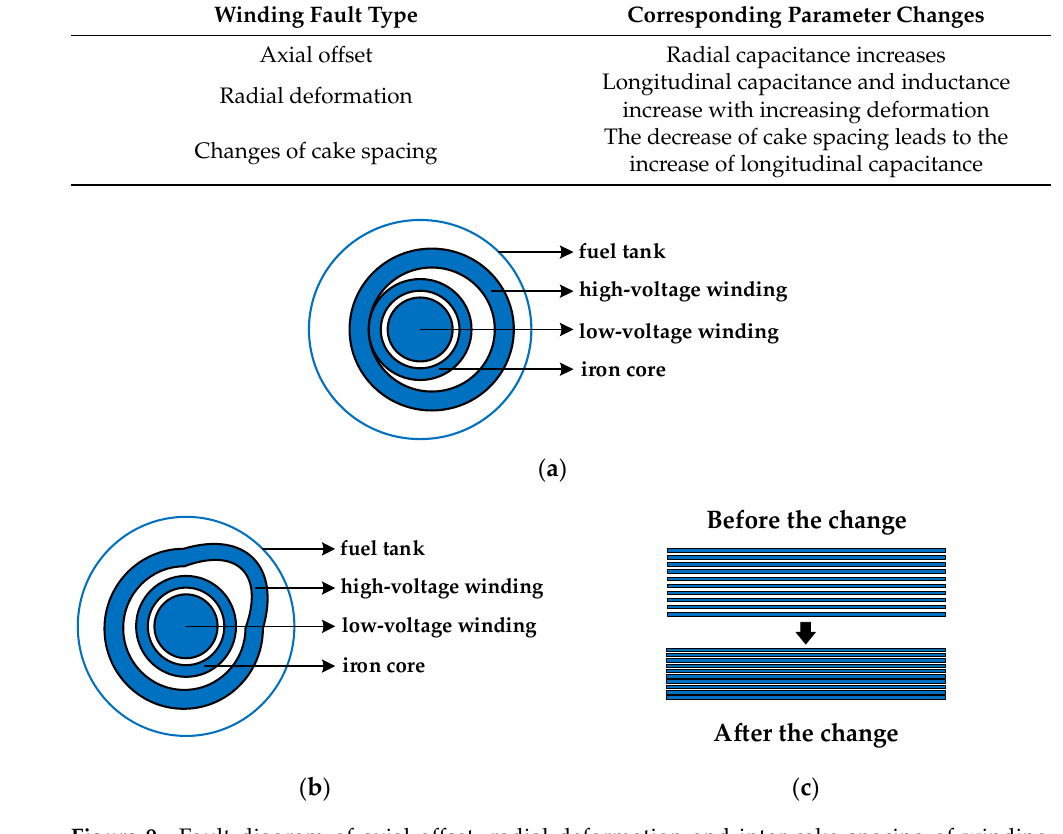
Figure 9. Fault diagram of axial offset, radial deformation and inter-cake spacing of winding: ( a ) Axial offset diagram of winding; ( b ) Radial deformation diagram of winding; ( c ) The change of inter-cake spacing. Table 5. Changes of winding deformation corresponding parameters.